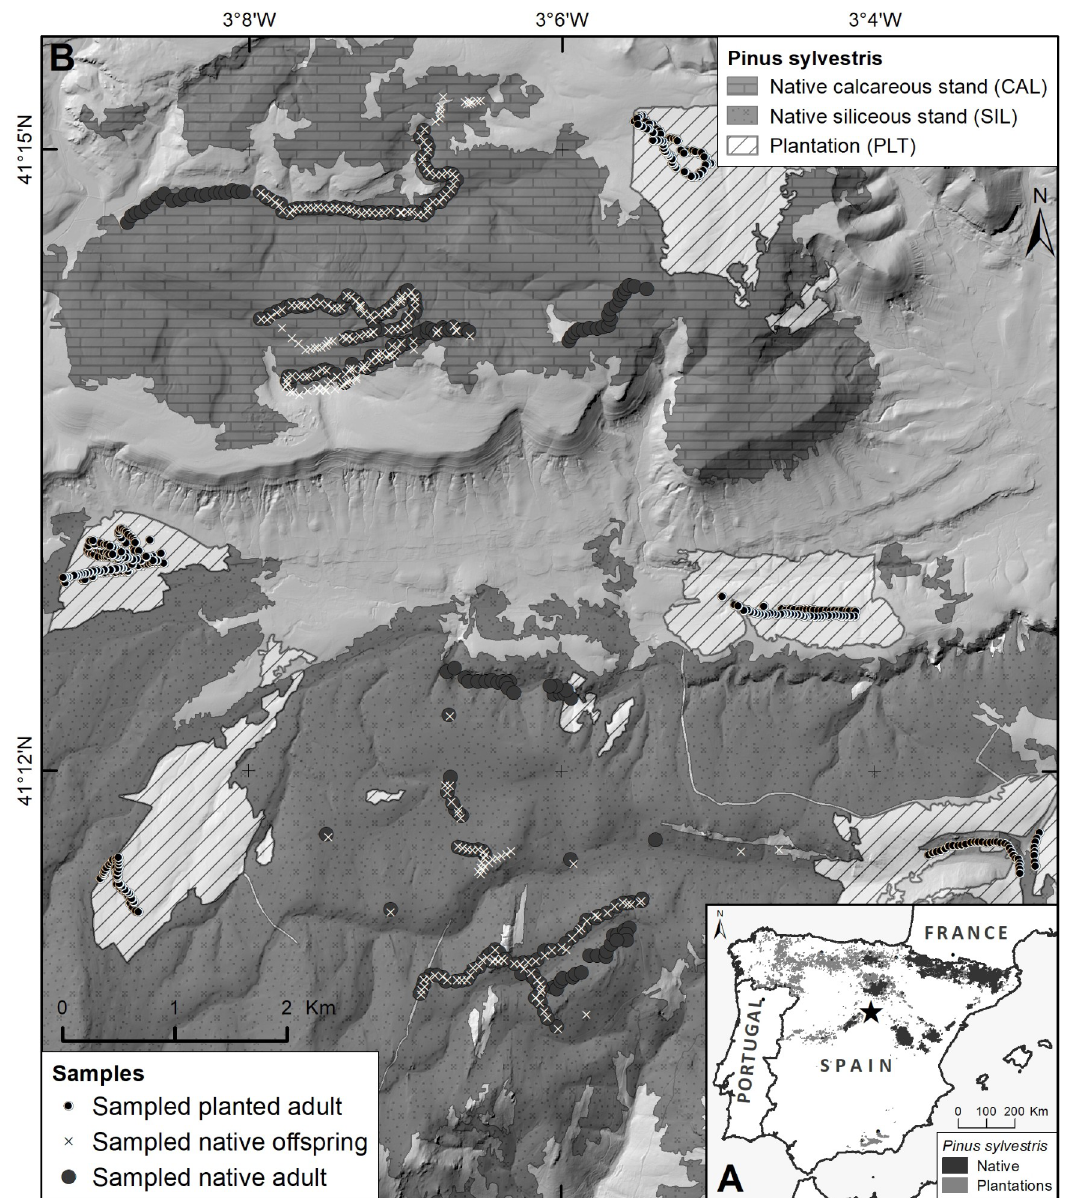
Fig 1. Maps of Pinus sylvestris study site in Sierra de Ayllo´n (Spain). (A) Location of Sierra de Ayllo´n (marked with a star) and distribution of native and planted populations of the species within the Iberian Peninsula. (B) Distribution of sampled native and planted adult and offspring samples within the calcareous and siliceous populations. BDLJE CC-BY 4.0 ign.es, MDT05 2015 CC-BY 4.0 scne.es, MFE50_19 2003